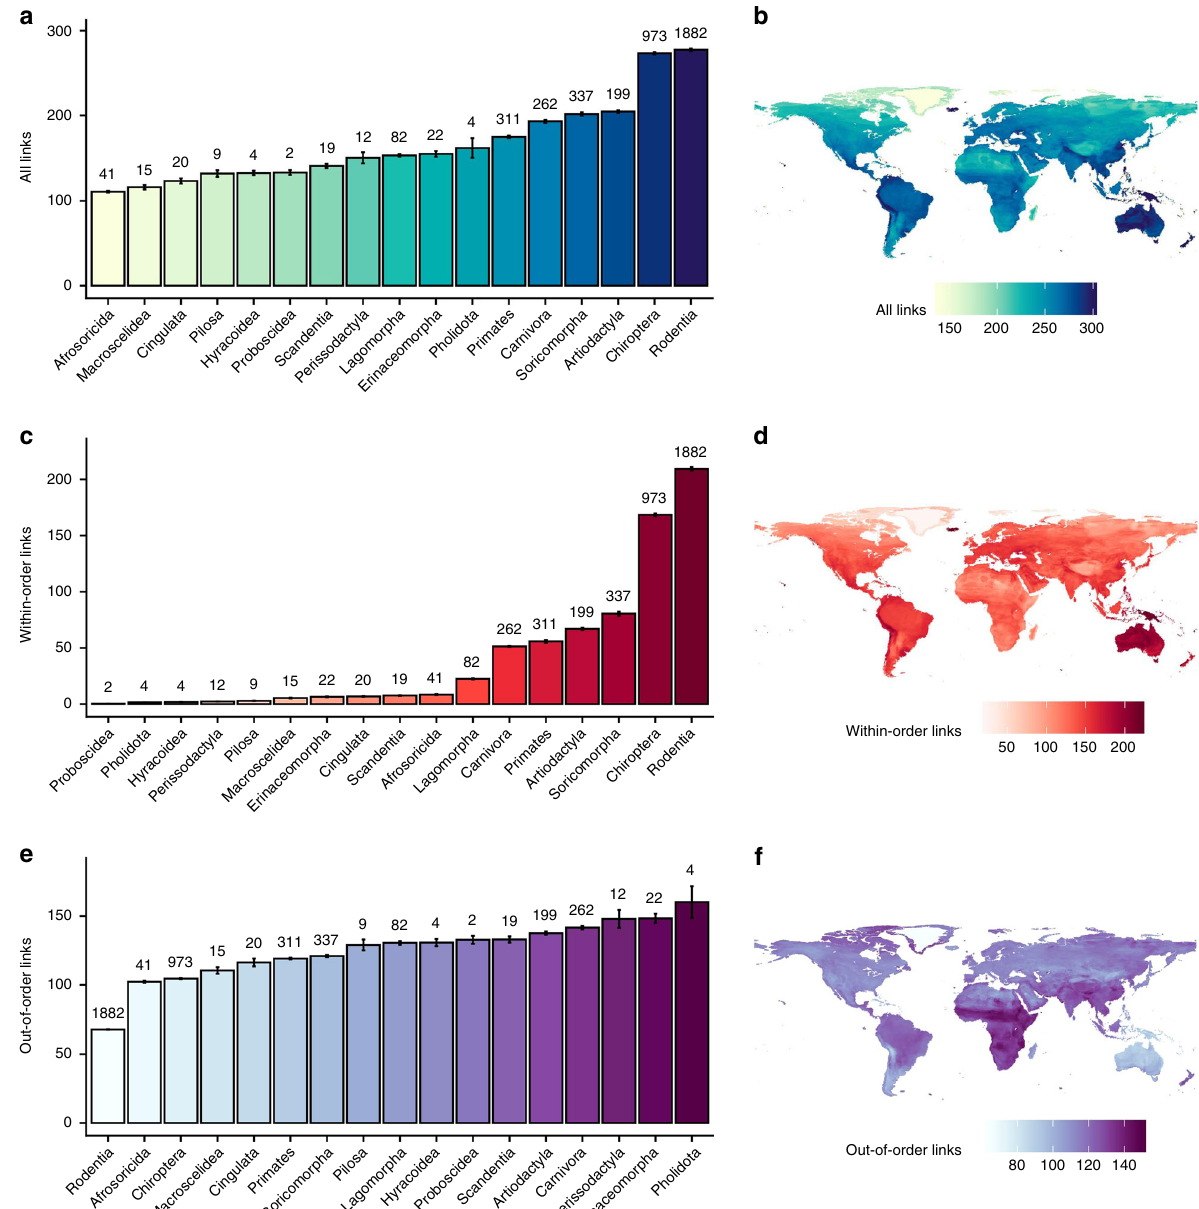
Fig. 3 Taxonomic and geographic patterns of mean predicted viral sharing link numbers (degree centrality). Top row: all viral sharing links; middle row: viral sharing links with species in the same order; bottom row: viral sharing links with species in another order. a , c , e Average species-level viral sharing link numbers for mammalian orders in our dataset. Bars represent means; error bars represent standard errors. b , d , f Geographic distributions of mean viral sharing link numbers. Distributions were derived by summing the viral sharing link numbers of all species inhabiting a 25 km 2 grid square and dividing them by the number of species inhabiting the grid square, giving mean degree number at the grid